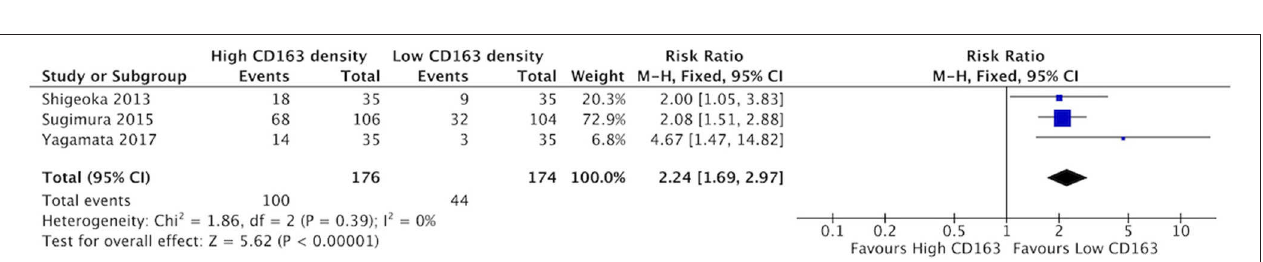
FIGURE 7 | High CD163 + TAM density is associated with higher rates of vascular invasion.